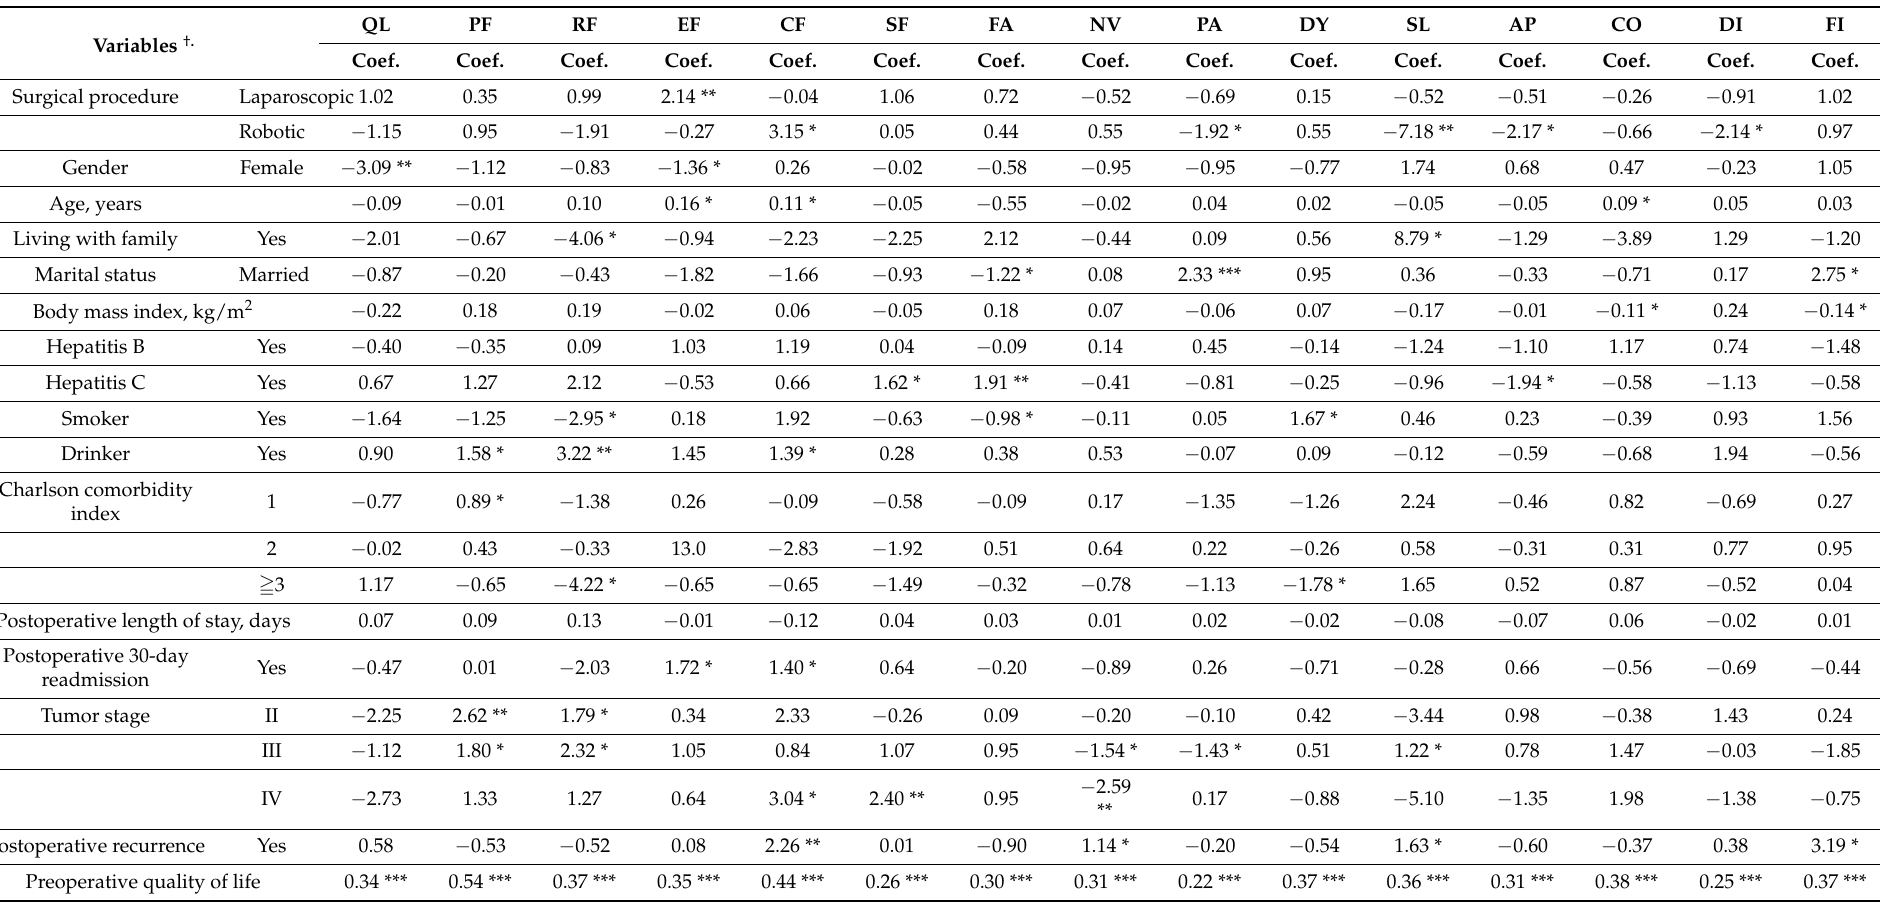
Table 3. Predictors of each European Organization for Research and Treatment of Cancer Quality of Life Questionnaire Core 30 (EORTC-QLQ-C30) subscale after hepatocellular carcinoma surgery over a 5-year